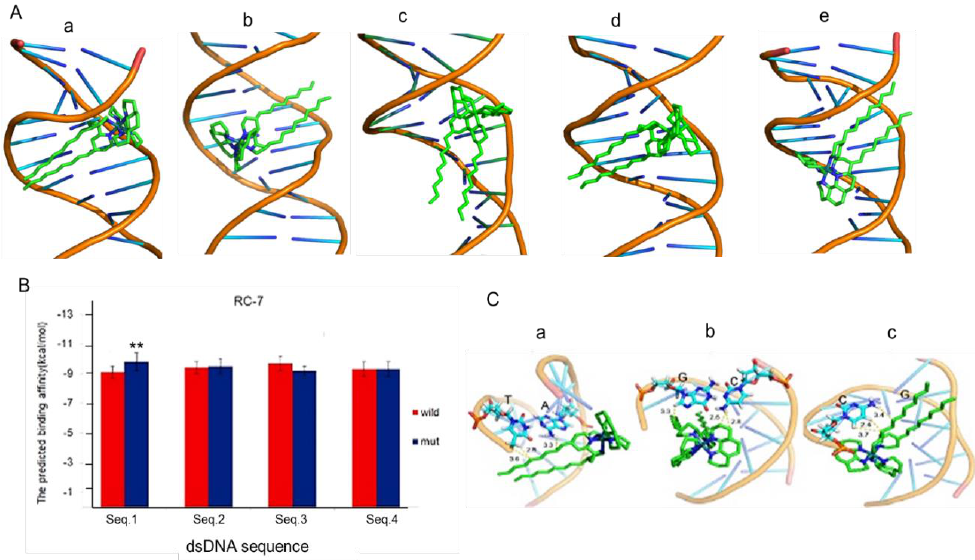
Figure 6. Molecular docking of RC-7 and mtDNA fragments. ( A ) Molecular docking of RC-7 with five mutant dsDNA (Table 1) by using PyMOL. (a) seq.1_mut. (b) seq.1_mut2. (c) seq.2_mut. (d) seq.3_mut. (e) seq.4_mut. ( B ) The binding affinities for RC-7 and four dsDNA sequences. Wild and mut respectively represent wild-type dsDNA and mutant dsDNA. ** p < 0.01 compared with the wild-type dsDNA. ( C ) RC-7 interacting with the mtDNA fragments such as (a) seq.1_wild. (b) seq.1_mut. (c) seq.1_mut2. The yellow dotted lines and values represent the three nearest distances (Å) between RC-7 and dsDNA mutation sites. Table 2. Binding affinities (kcal/mol) and three nearest distances (Å ) of RC-7 and mtDNA (57T; 57T > C; 57T > G).